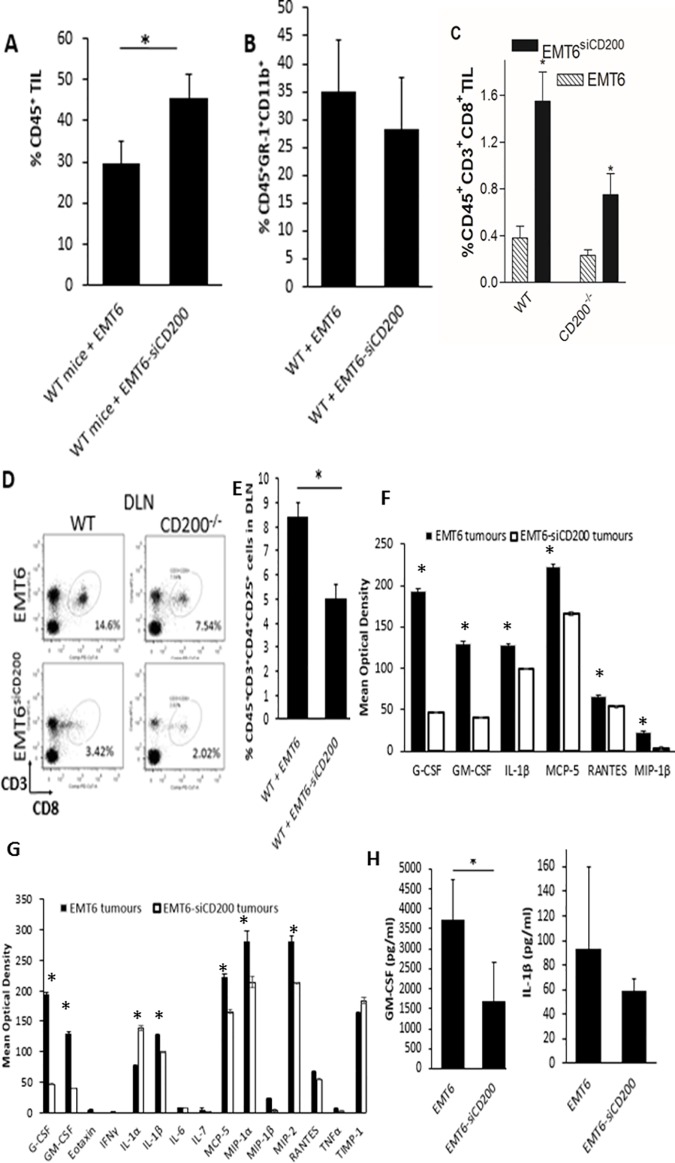
EMT6 and EMT6siD200 tumor microenvironments in WT and CD200-/- female mice.A) EMT6 and EMT6siCD200 tumors were harvested from WT mice at day 20 post tumor cell injection. Tumors were digested, stained for the CD45 cell-surface molecule, and analyzed by flow cytometry. Data show mean (±SD) of 4 mice/group. *p<0.05. B) and C). EMT6 and EMT6siCD200 tumors grown in WT and CD200-/- mice were digested and stained for CD45+GR-1+CD11b+ cells (b), and CD45+CD3+CD8+ (c) cells. Panels show (mean±SD) from 4 mice/group after gating on CD45+ cells. *p<0.05, **p<0.01. D) and E). DLN from WT and CD200-/- mice with EMT6 and EMT6siCD200 tumors were digested and stained for CD45, CD3, CD4+, CD25+ and CD8 cell-surface markers. Panels in D) show representative dot plots from 4 mice/group after gating on CD45+ cells. Data in E) shows % CD4+CD25+ cells in DLN gated on CD45+CD3+ cells. >25% stained by intracellular staining for Foxp3+ (not shown). F) Relative levels of G-CSF, GM-CSF, IL-1β, MCP-5, MIP-1β, and RANTES expressed in EMT6 and EMT6siCD200 tumors grown in WT mice were assessed using a proteomics array. Data show mean (±SD) optical density (OD) from 3 independent tumor samples of each type. * indicates p<0.05 compared with EMT6siCD200 tumors. G) Equivalent proteomics array (to that shown in panel F) performed using aliquots of 24hr supernatants from tumor cells shown in panel F). Data show mean (±SD) of 4 tumors/group. * indicates p<0.05 compared with EMT6siCD200 tumors. H) Levels of GM-CSF and IL-1β in 24hr supernatant (panel G) from EMT6 and EMT6siCD200 tumors cultured in αF10 as assessed by ELISA. Data show mean (±SD) of 4 tumors/group. *p<0.05.